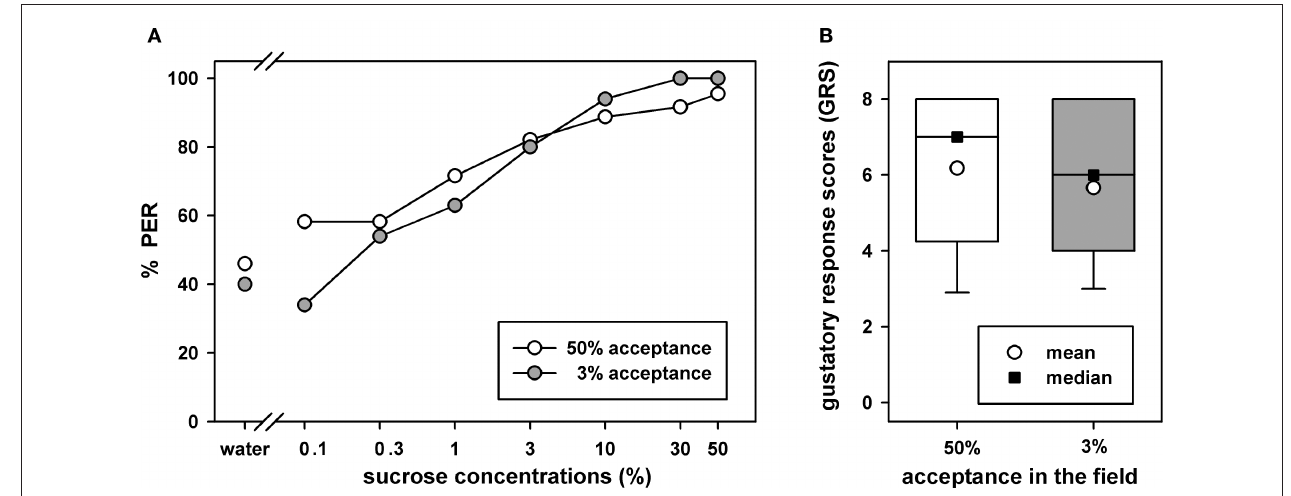
FiguRE 2 | PER responsiveness for different concentrations of sucrose in two groups of bees which either had acceptance thresholds ≤ 3% or ≥ 50% in the field. (A) Sucrose concentration dependence of the PER. The abscissa shows the applied stimuli starting from water to 50% sucrose. The ordinate